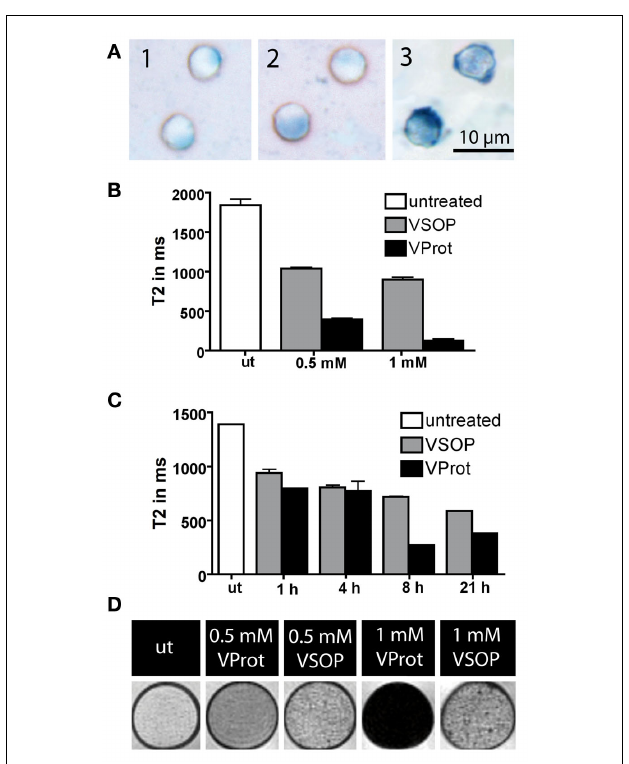
FIGURE 2 | InT cells, diffusely distributed intracellular magnetic nanoparticles are present after labeling with 1mM Fe/mlVProt for 1h (A1), 4h (A2), and 10h (A3). NMR transverse relaxation time (T2) after T cell labeling was estimated by relaxometry. Comparing the labeling efficacy ofVSOP to that of protamine-complexedVSOP (VProt), we found that after 10h of incubation,T2 times were significantly reduced ( p < 0.001) inVProt samples already at low concentrations (B) . In a longitudinal experiment we noted a continuous reduction ofT2 times at a concentration of 1mM Fe/ml over 21h inVSOP-labeledT cells. In contrast,VProt labeled T cells reached a maximum already after 8h of incubation (C) . In agarose phantoms containingT cells at a concentration of 1000cells/ μ l, imaged on a 7T scanner, hypointensities caused byVProt labeled cells inT2 ∗ -weighted